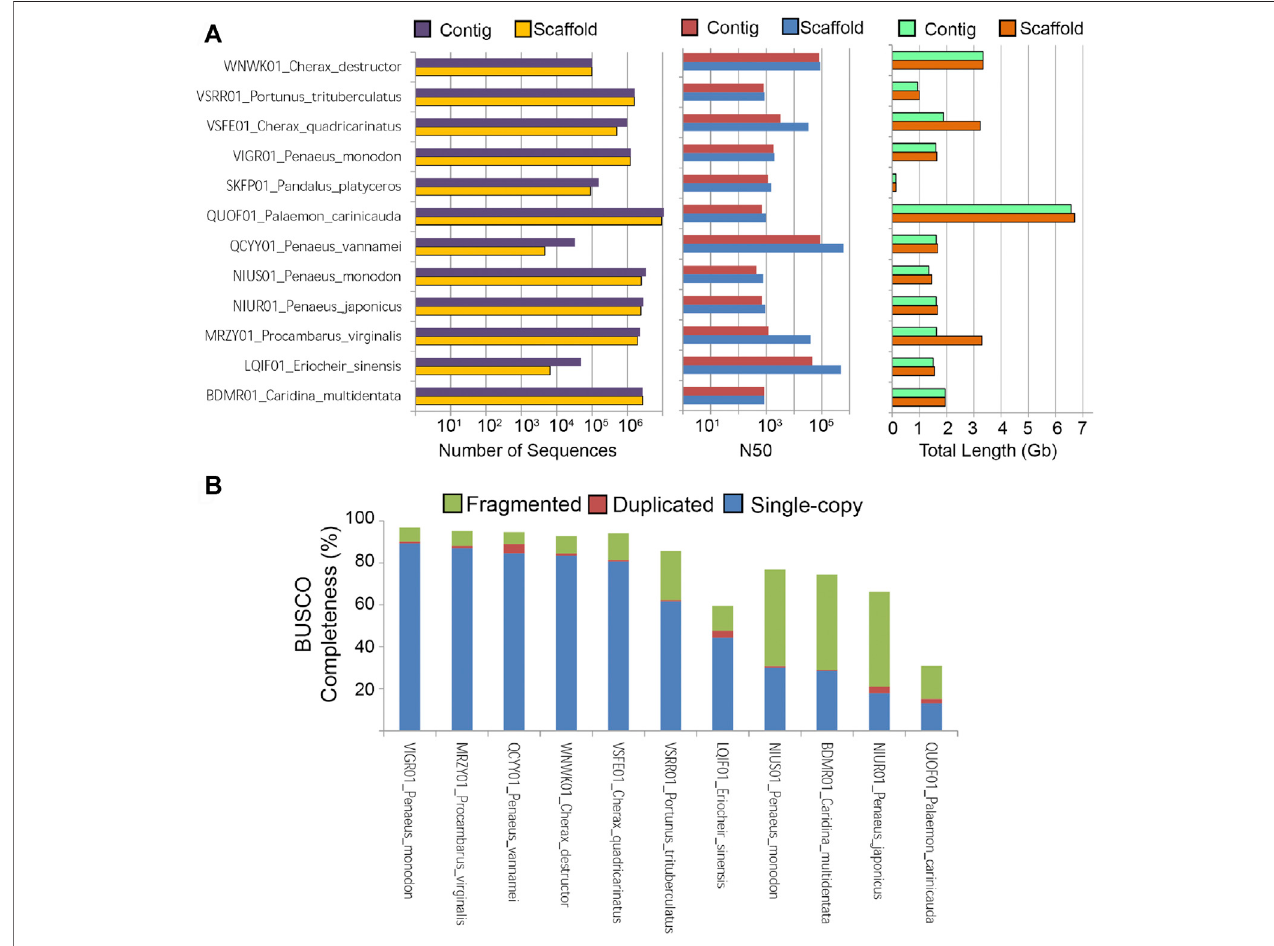
FIGURE 2 | Statistics of publicly available decapod crustacean genome assemblies. (A) Number of sequences, Genome N 50 , and total assembled length (B) BUSCO completeness based on the Arthopoda ortholog dataset.